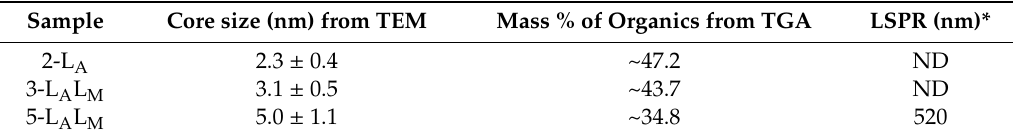
Table 1. Size, composition, and optical properties of nanoparticles (NPs). LSPR—localized